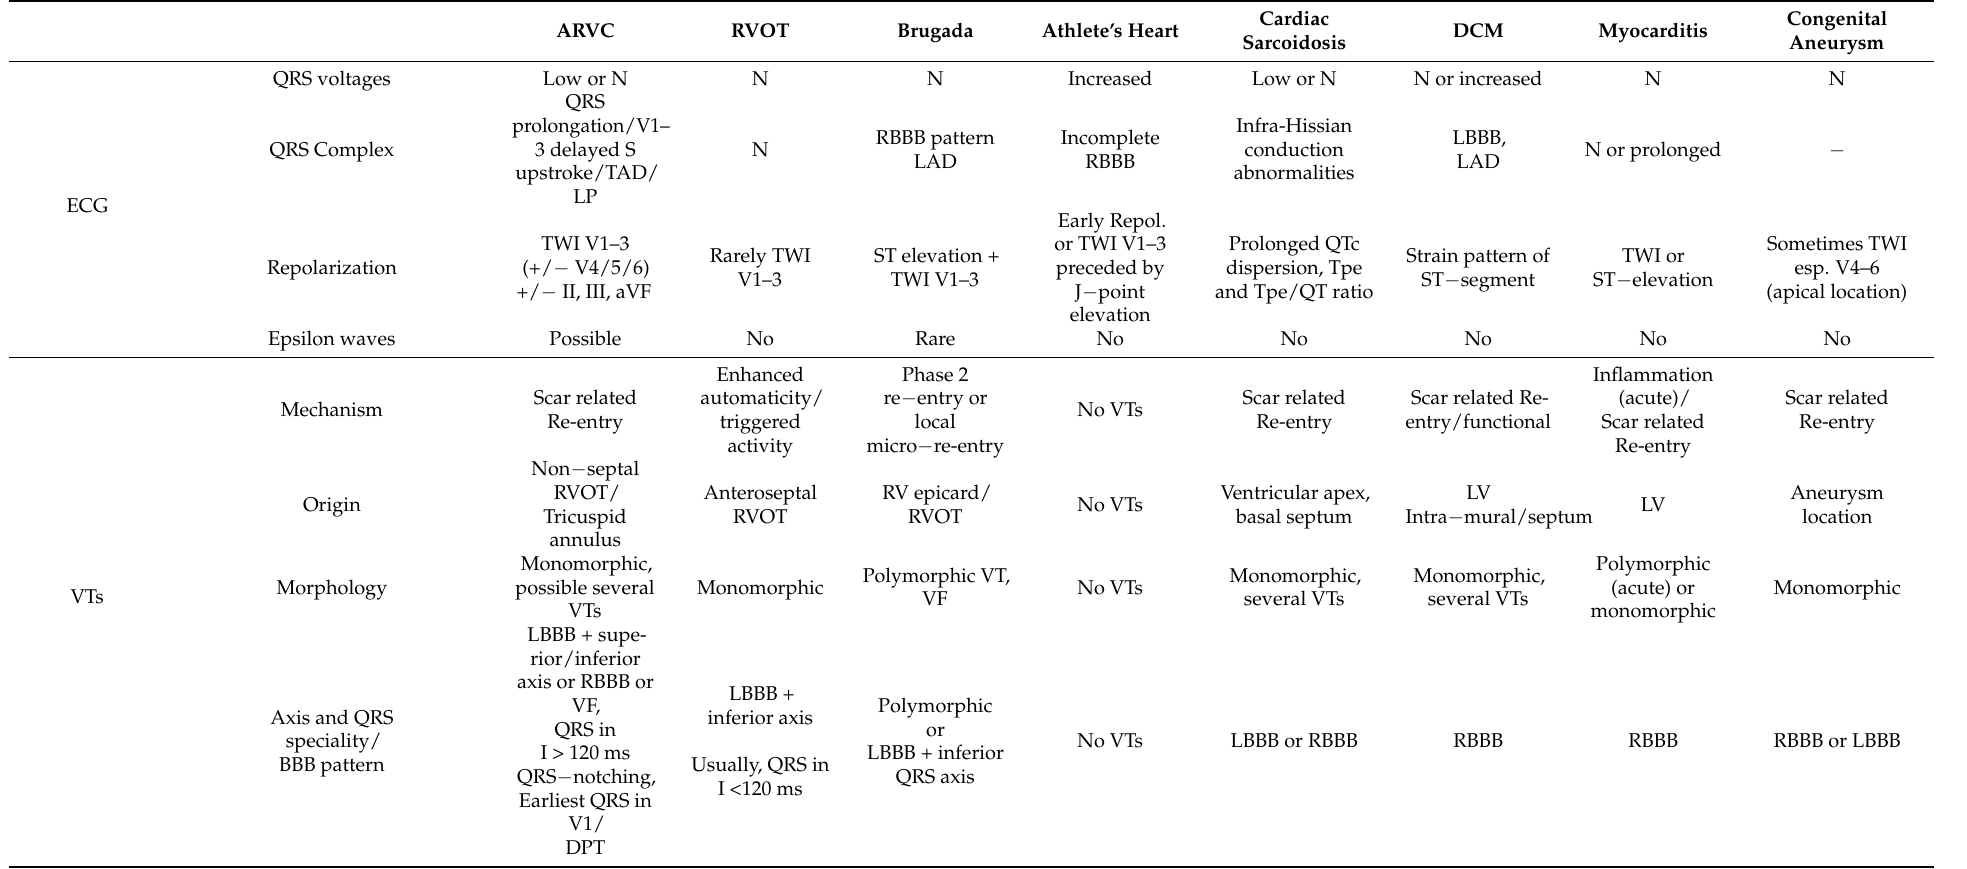
Table 1. Arrhythmogenic Right Ventricular Cardiomyopathy and Differential Diagnosis with Diseases Mimicking its Phenotypes. Abbreviations: DPT = Delayed precordial transition, LAD = Left axis deviation, LBBB = Left Bundle Branch Block, LP = Late potential, N = Normal, RBBB = Right Bundle Branch Block, RVOT = Right ventricular outflow tract, TAD = Terminal activation delay, TWI: T-Wave Inversion, VF Ventricular Fibrillation, VT = Ventricular Tachycardia, WMD = Wall Motion